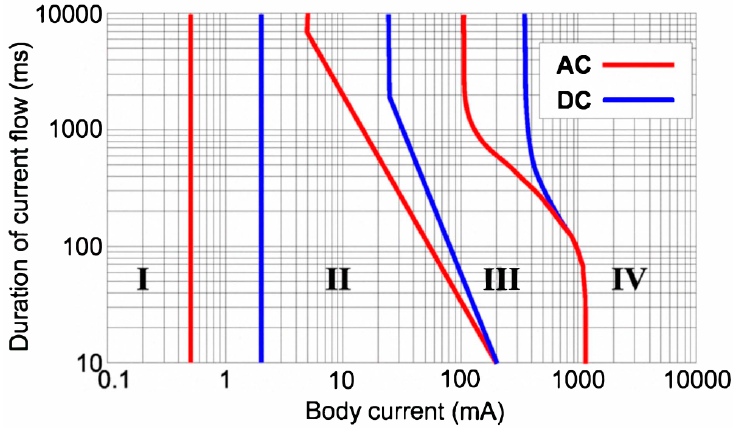
Figure 4. Characteristic curve of body current vs. duration of flow, IEC/TR 60479-5 [37].